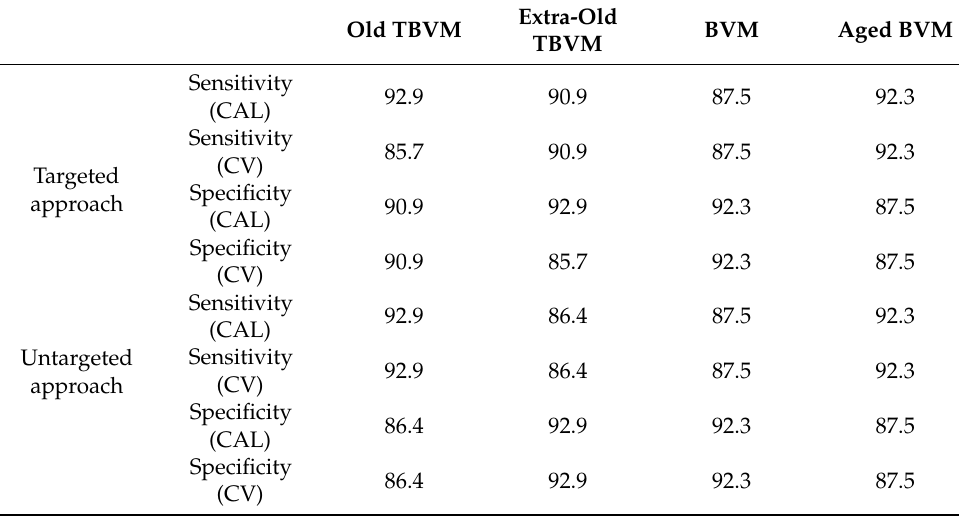
Table 3. Sensitivity and specificity results of classification of vinegar samples from Modena province of linear discriminant analysis models for the targeted and the untargeted approaches. Results are expressed as